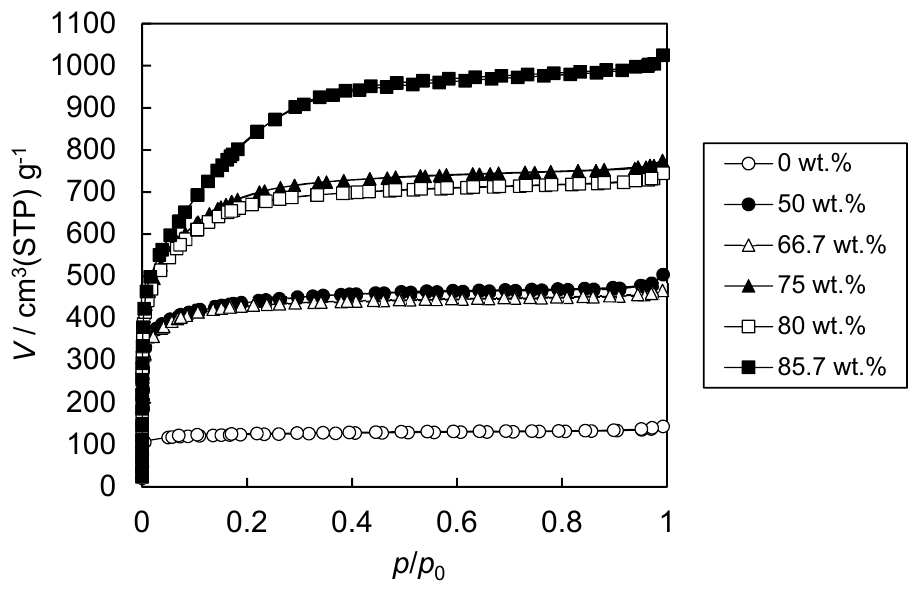
Figure 1. N 2 adsorption isotherms of the samples at 77 K.